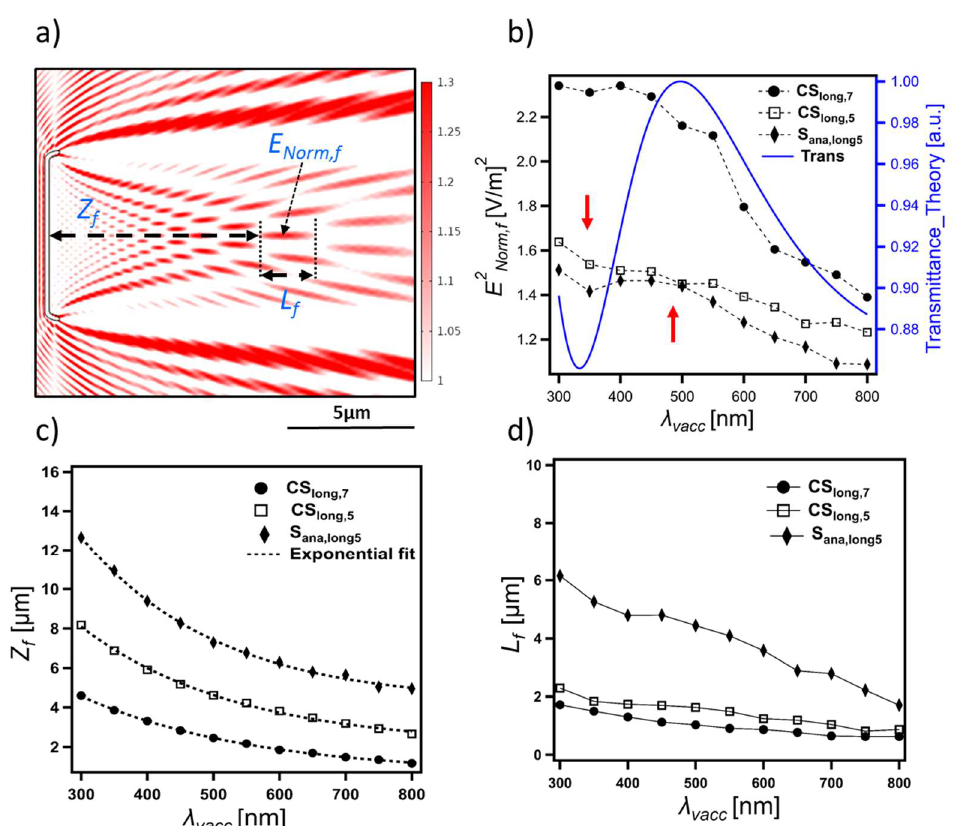
Figure 7. ( a ) The interference pattern of CS long,5 at λ vacc 300 nm in air and the focusing parameters of interest; the color code emphasizes the focusing spots. ( b ) The λ vacc dependency of the intensity E 2Norm,f of selected spots (e.g., the spot illustrated in ( a ) for CS long,5 ) compared to the thin-film inter- ference spectrum of the transmittance expected from theory (blue); the red arrows indicate places where the thin-film interference affects the intensity of the spots. The extracted E Norm,f has an error up to ± 0.02 V/m associated with the local variation in the strength of the selected spot. ( c ) The λ vacc dependency of Z f and ( d ) L f of the same selected spots in